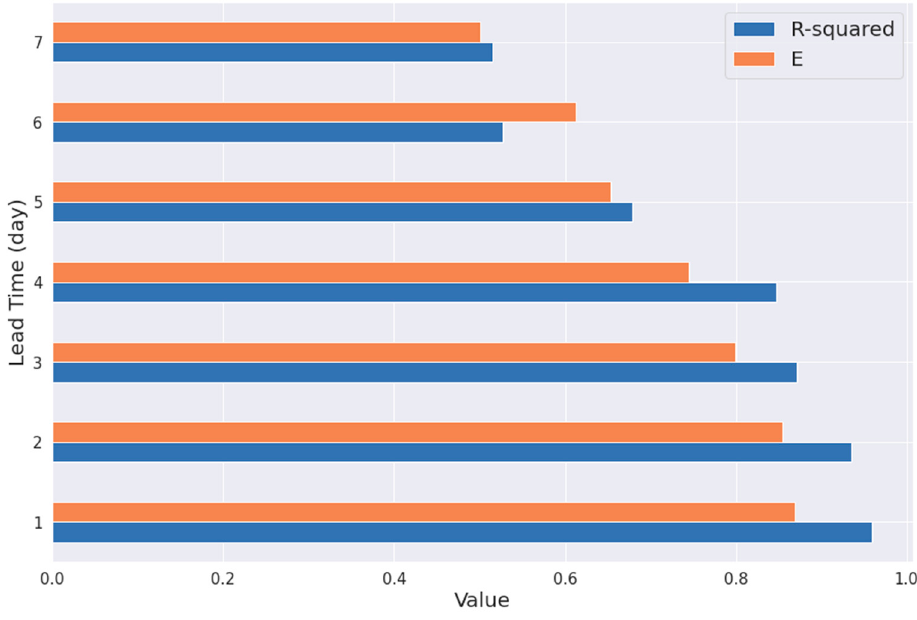
Figure 10. Performance of LSTM neural network model for various lead